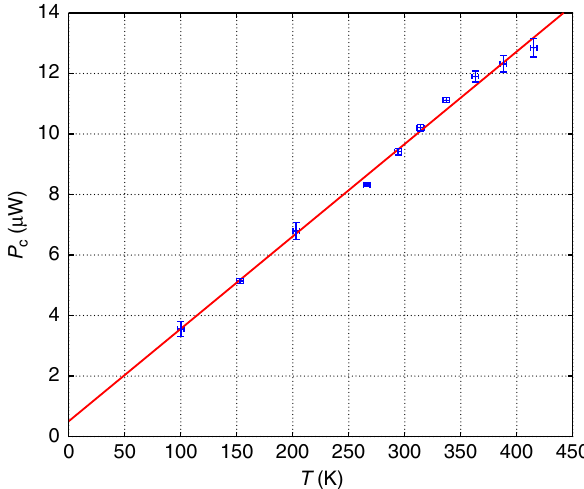
Fig. 3 the condensation power p 0 dependence on temperature T for various constant powers, obtained by the intersections of the lines in Fig. 3 with any vertical line (constant P ) that gives a ≈ P − aT dependence as the theory predicts. Extrapolation p 0 to the T -axis gives the BEC transition temperatures ( p 0 = 0) that match the theoretical result of T c = P / a . For example, for P = 14 μ W, it gives a BEC transition at T ≈ 451 K. c